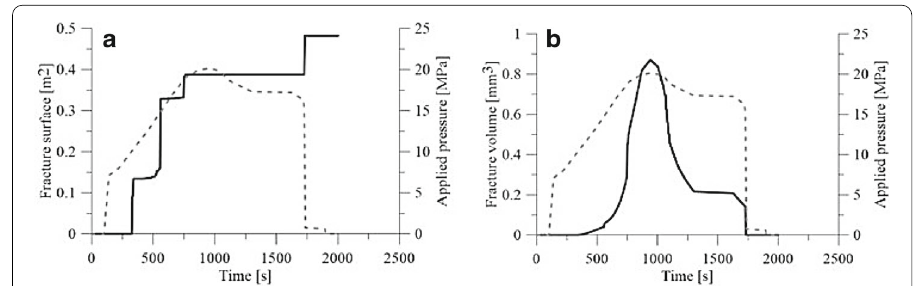
Fig. 5 Laboratory test. Numerically obtained time history of a fracture surface and b fracture volume (solid line). The time history of the experimental fluid pressure (dashed line) is reported for the sake of comparison